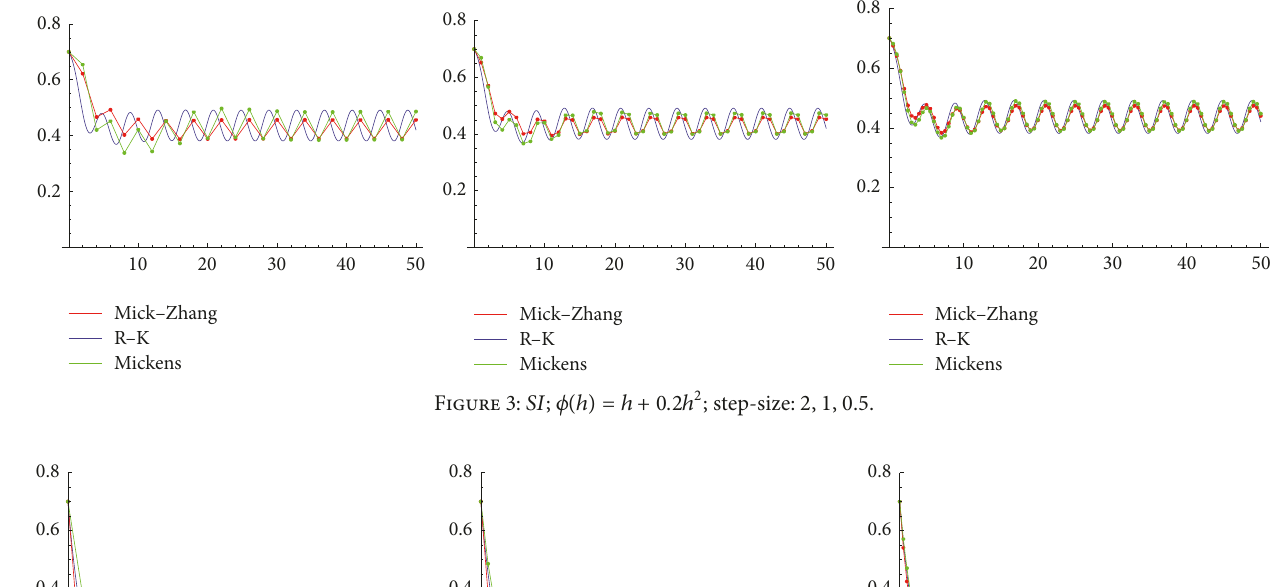
Figure 3: 𝑆𝐼 ; 𝜙(ℎ) = ℎ + 0.2ℎ 2 ; step-size: 2 , 1 , 0.5 .